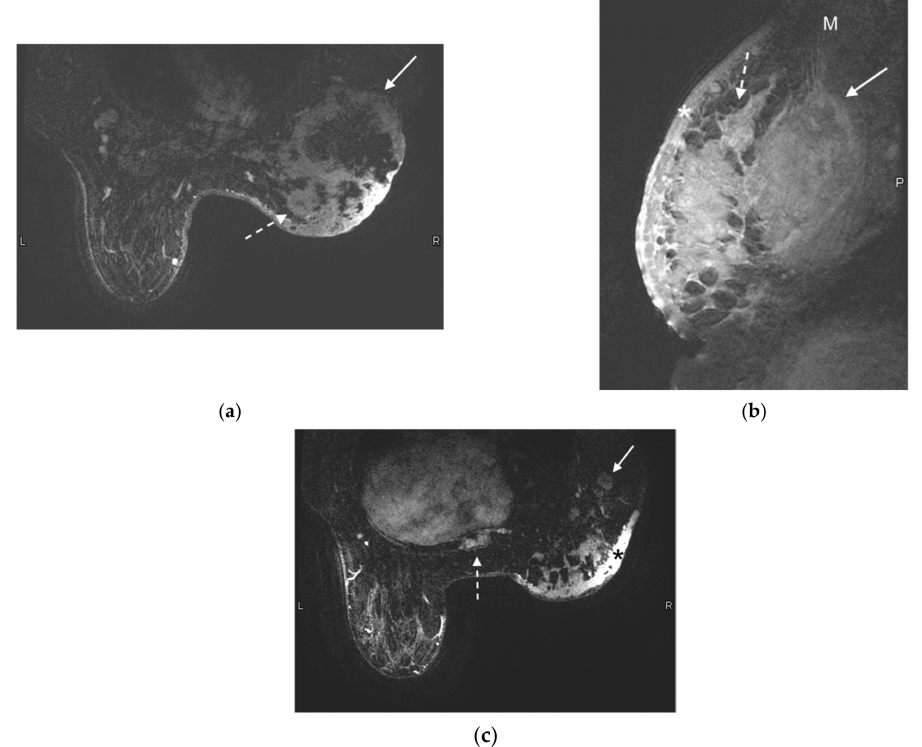
Figure 3. 55-year-old woman presented with a palpable breast mass and asymmetric breast size. Mammogram and ultrasound showing a large mass are not shown. MRI was performed to evaluate for extent of disease. ( a ) Axial contrast- enhanced T1-weighted fat-suppressed image demonstrates a 13 cm ring-enhancing centrally necrotic lateral right breast mass (solid arrow). Additional rim-enhancing centrally necrotic satellite lesions are noted at the medial aspect of the breast (dashed arrow). ( b ) Sagittal contrast-enhanced T1-weighted fat-saturated image demonstrates a large irregular heterogeneously enhancing right breast mass invading the right pectoralis muscle (arrow). The edge of the normal pectoralis muscle (M) is seen superiorly. Diffuse skin thickening and enhancement (*) is compatible with skin involvement, and satellite lesions (dashed arrow) are redemonstrated. p demarcates the posterior aspect of the image. ( c ) Axial contrast-enhanced T1-weighted fat-saturated image demonstrates abnormally enlarged and enhancing right axillary lymph nodes (arrow) and an enhancing metastatic bone lesion in the sternum (dashed arrow). Right breast skin thickening (*) is again